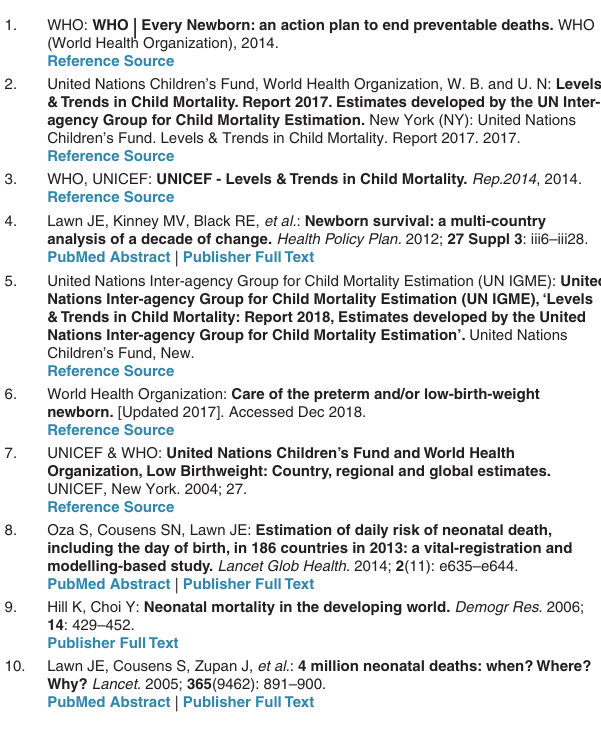
Figshare: Cross et al. GatesOpenResearch SCC1525v2_NeoInnate_ Consent form Route 2_Part 1_ (Umbilical Cord Blood Collection) - Labour Ward_v1.1-Approved 8Nov17. https://doi.org/10.6084/ m9.figshare.8069246.v1 50